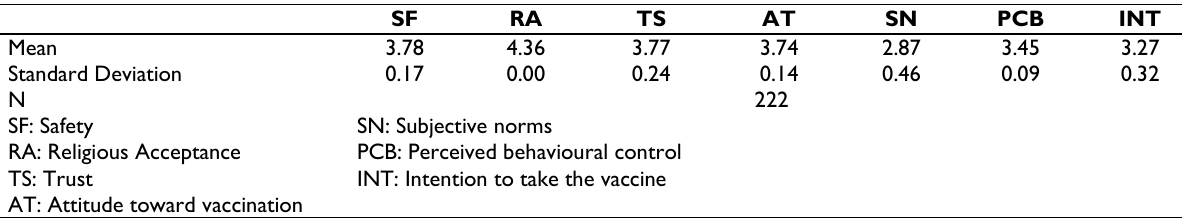
Table 1. Descriptive